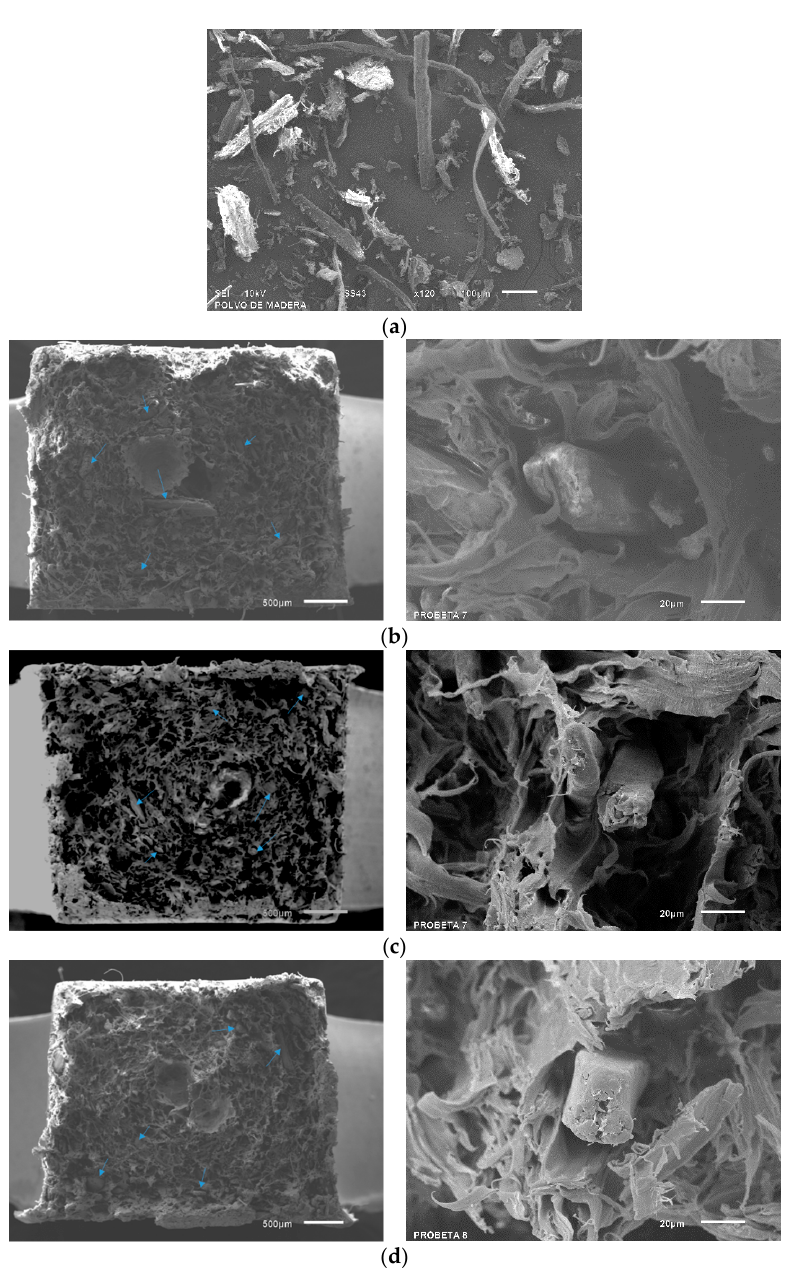
Figure 6. SEM micrographs of ( a ) WF and failure surfaces of tensile specimens corresponding to ( b ) PP/WF-5901, ( c ) PP/WF-5951, and ( d ) PP/WF-0218. Lower magnifications are to the left and higher magnifications to the right.